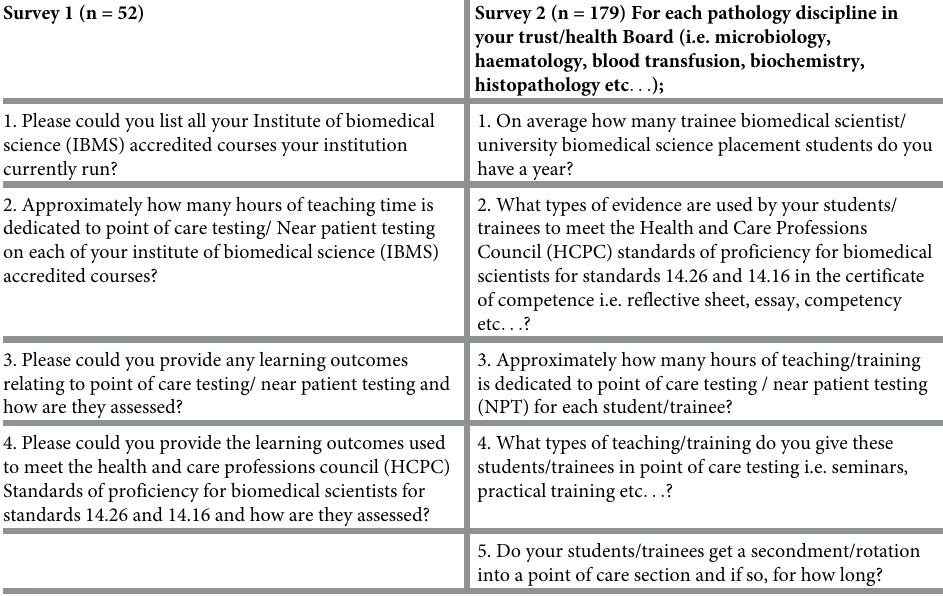
Table 1. The survey questions which were used to assess teaching and training of point of care testing at universi- ties (survey 1) and national health service laboratories (survey 2). Survey 1 (n =